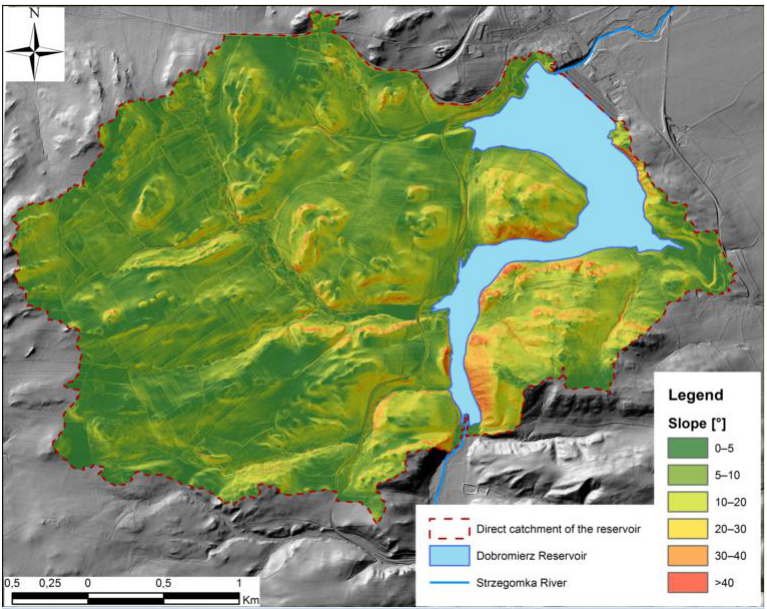
Figure 2. Slope map of the direct catchment of the Dobromierz Reservoir. Water 2018 , 10 , x FOR PEER REVIEW